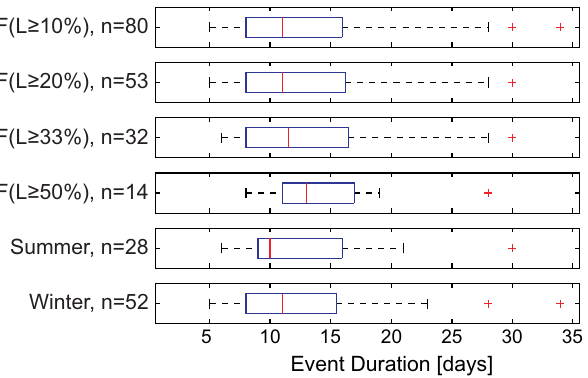
Fig. 8. Event duration, stratified by spatial extent and season. n indicates the number of trans-basin floods F which fall into any par- ticular class. In the box plots, the central mark denotes the me- dian and the edges of the box the 25th and 75th percentiles. The whiskers extend to the most extreme data points which corresponds to approximately ± 2.7 σ , and outliers are marked by the red crosses.